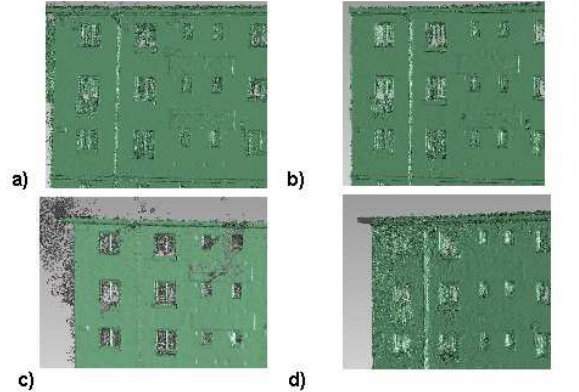
Figure 5. Point cloud from: a) Pentax 645D; b) Canon EOS 450D; c) Sony CyberShot; d) iPhone 5s